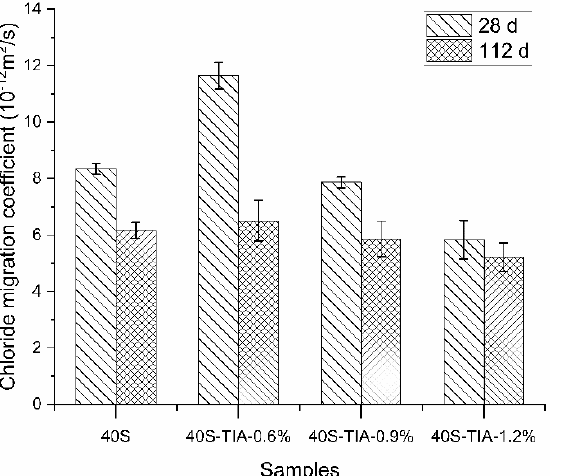
Figure 7. The chloride migration coefficient of concrete with 0%, 0.6%, 0.9%, and 1.2% NPI at 28 days and 112 days, respectively, by RCM. and 112 days, respectively, by